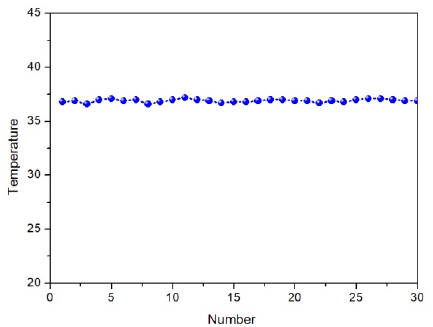
Figure 4. Temperature distribution curve of partial culture flask.